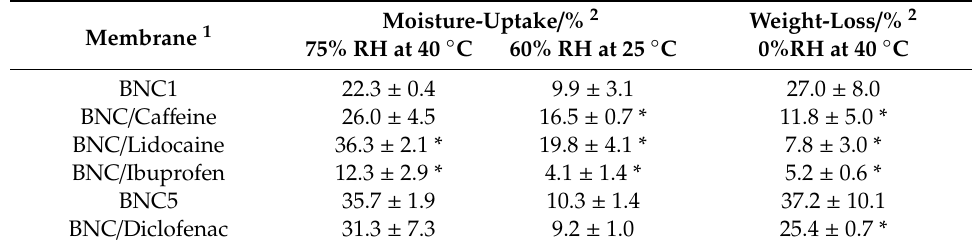
Table 2. Water-uptake and weight-loss after three months storage for plasticized BNC and API-loaded BNC membranes.